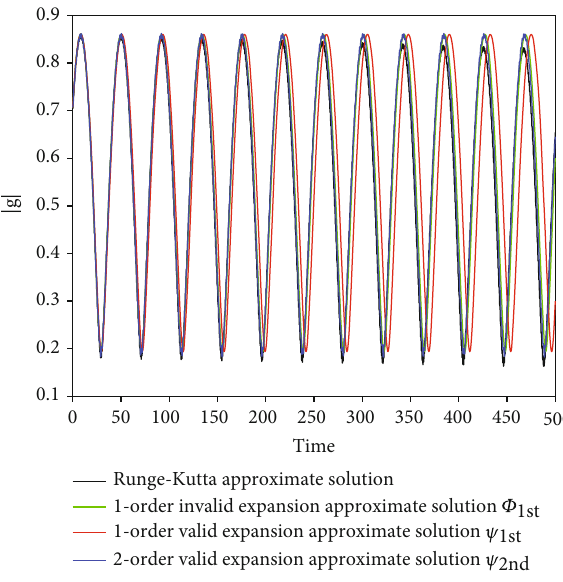
Figure 3: Valid and invalid RG approximate solutions of two-level systems near